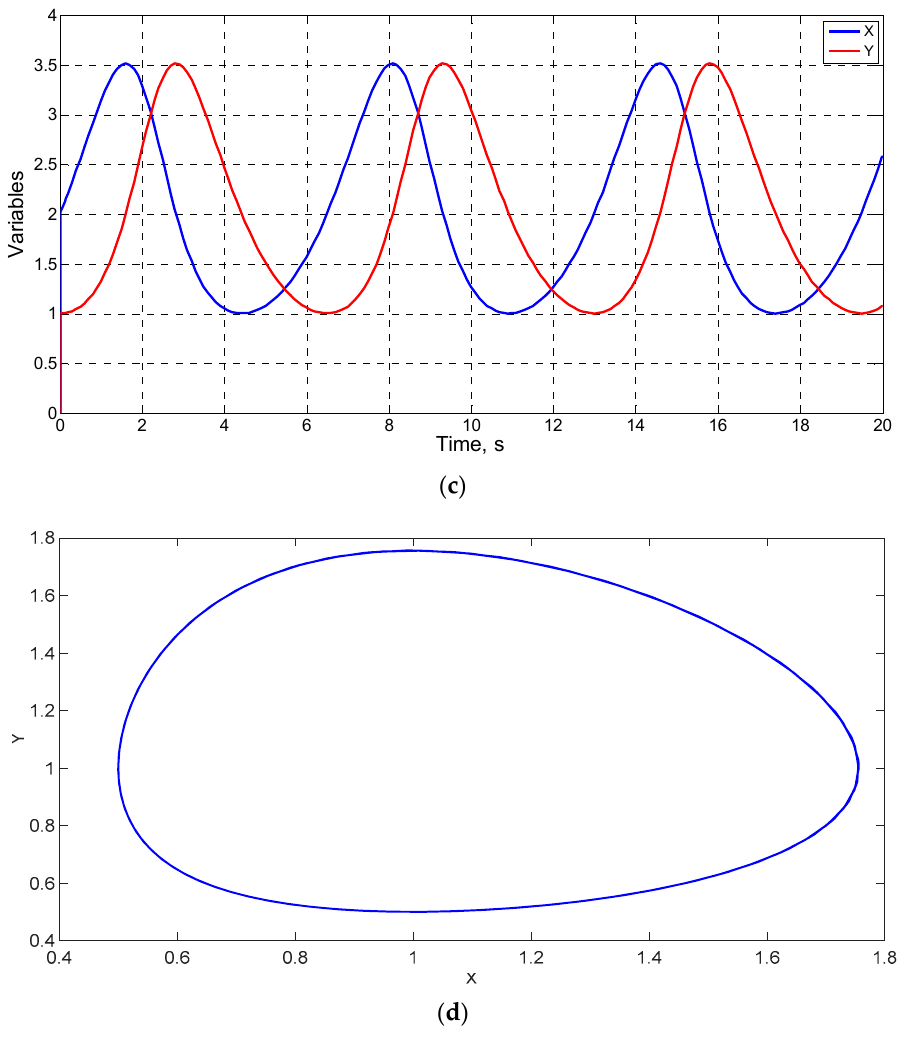
Figure 9. Concentrations of the variables x and y for case iv (Table 1). ( a ) Scenario X, ( b ) Scenario XI, ( c ) Scenario XII, and ( d ) phase plane of scenario X.